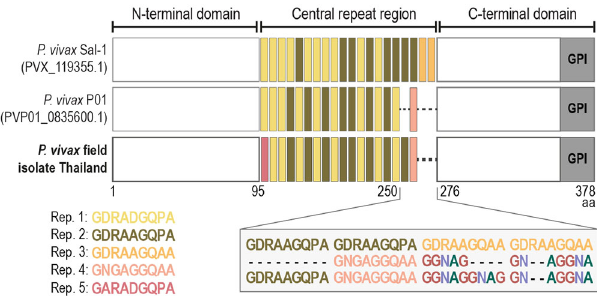
Fig. 1 Pv CSP amino acid sequence used for generation of Pb viVac and comparison with reference Pv genomes. Comparison of the Pv CSP sequence used for generation of Pb viVac with those of reference Pv genomes. Schematic representation of the N-terminal domain, central repeat region and C-terminal region, with color blocks representing different repeat motifs (Rep.). Inset shows alignment of the region between amino acids (aa) 250 and